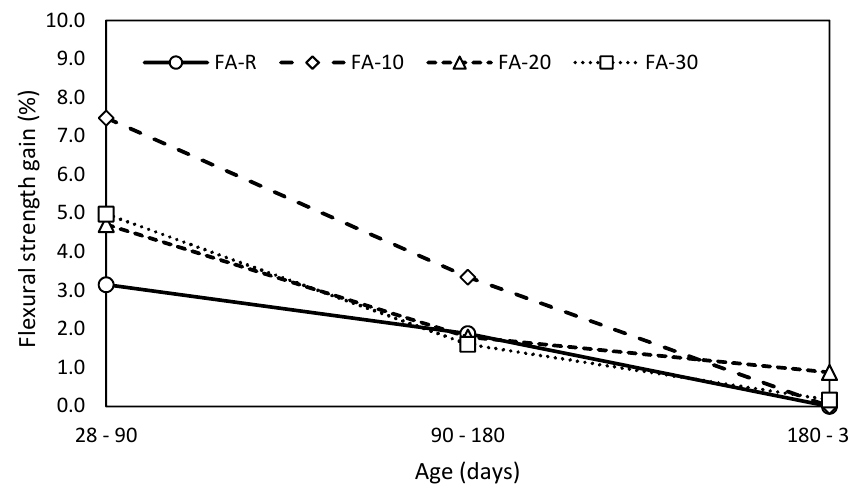
Figure 4. Gain of flexural strength in time.